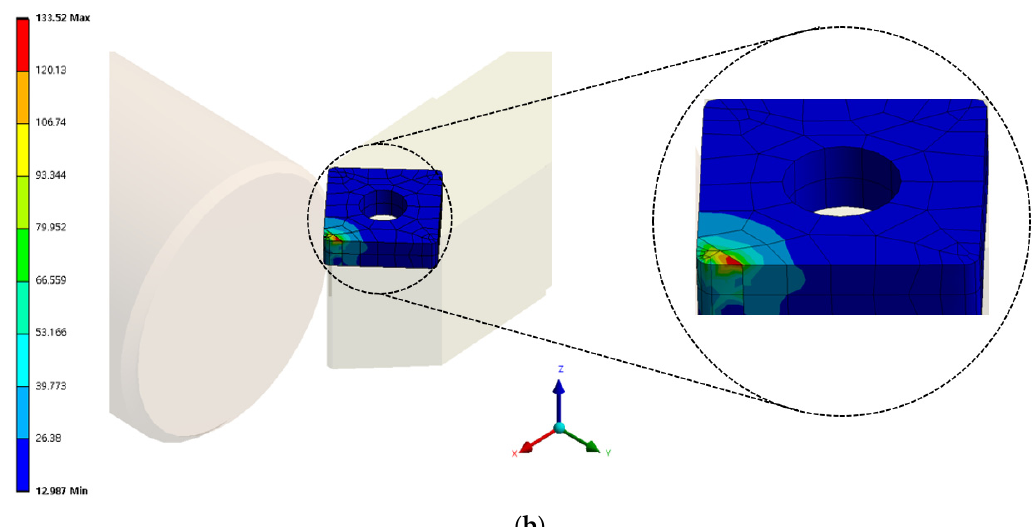
Figure 8. 3D model of the turning process for the FEM simulation: ( a ) temperature distribution of the cutting tool insert deposited by AM of titanium alloy powder; ( b ) temperature distribution of the ordinary cutting tool insert.